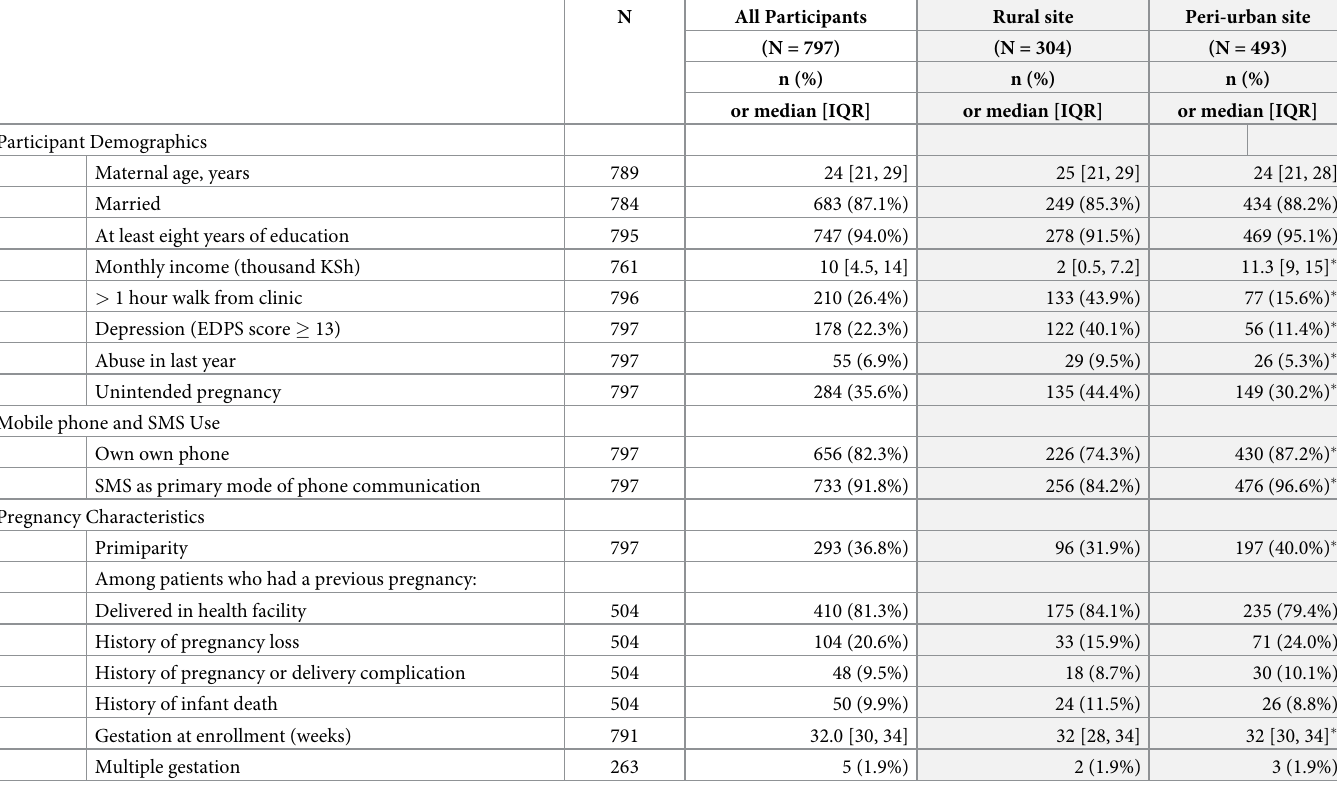
Table 1. Participant characteristics by